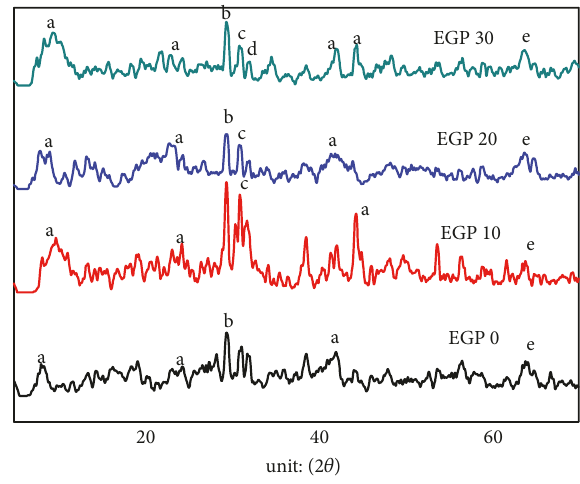
Figure 8: X-ray diffraction after seawater erosion for 56d.